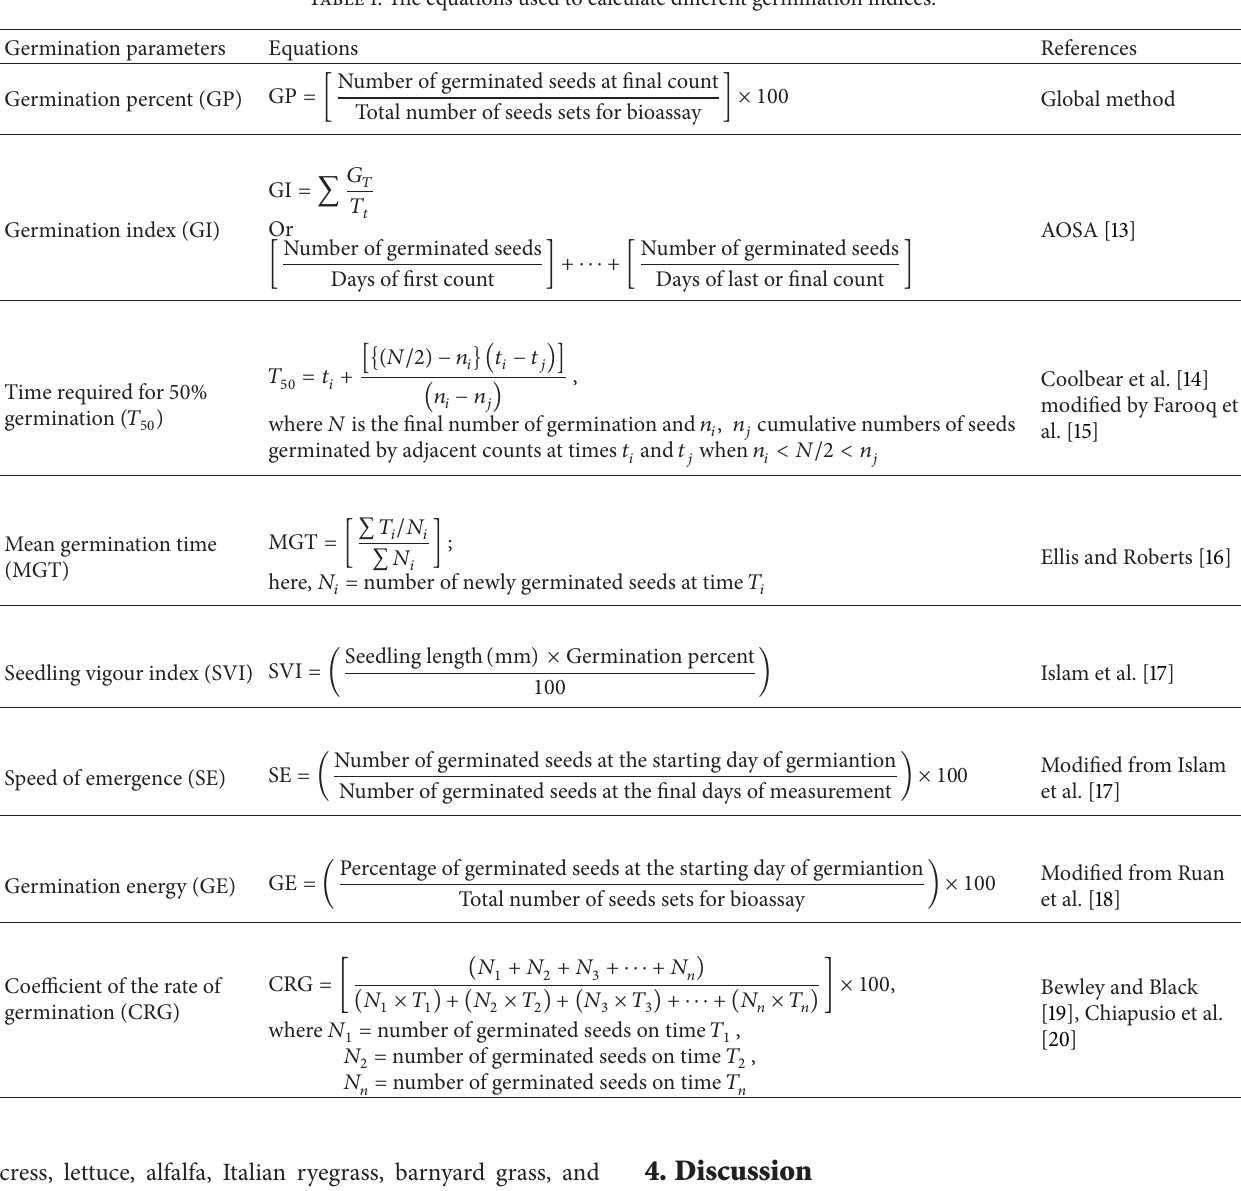
Table 1: The equations used to calculate different germination